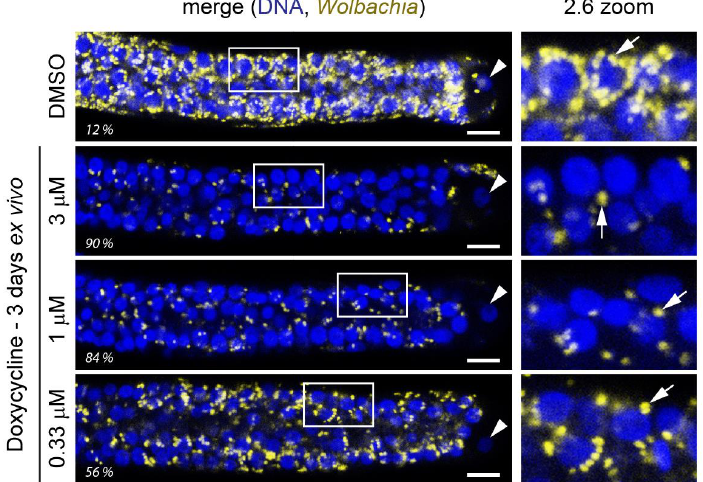
Figure 1. An ex vivo assay allows for rapid quantification of Wolbachia elimination in adult female worm ovaries near the distal tip cell due to compound treatment. Here, e ff ects of a 3-day doxycycline treatment on female adult B. pahangi worms is shown. Worms are extracted from jirds and treated in 24-well plates, with one worm per well and usually 2 worms per treatment condition (with total of four ovaries analyzed). Worms are fixed, their ovaries dissected out, and stained with Wolbachia -specific 16S rRNA fluorescent in situ hybridization (FISH) (yellow). The stained ovaries are mounted on slides with DAPI-containing mounting medium to stain DNA (blue) and their distal ends imaged using a confocal microscope. The Wolbachia -specific 16S rRNA FISH is quantified by high content image analysis and normalized to DMSO control samples (percent elimination indicated here for each displayed ovary). Panels on the right are the enlarged sections demarcated with a white box in the ovary images. Wolbachia w Bp is indicated with arrows and the distal tip cell nucleus with an arrowhead. Scale bar = 10 µ